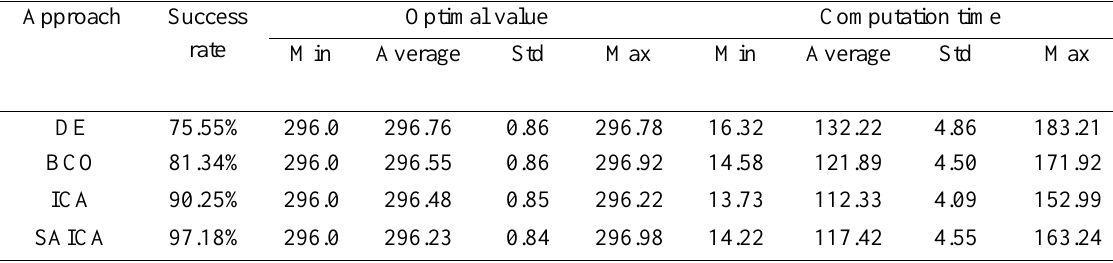
Table 12. The summary of results for the real case